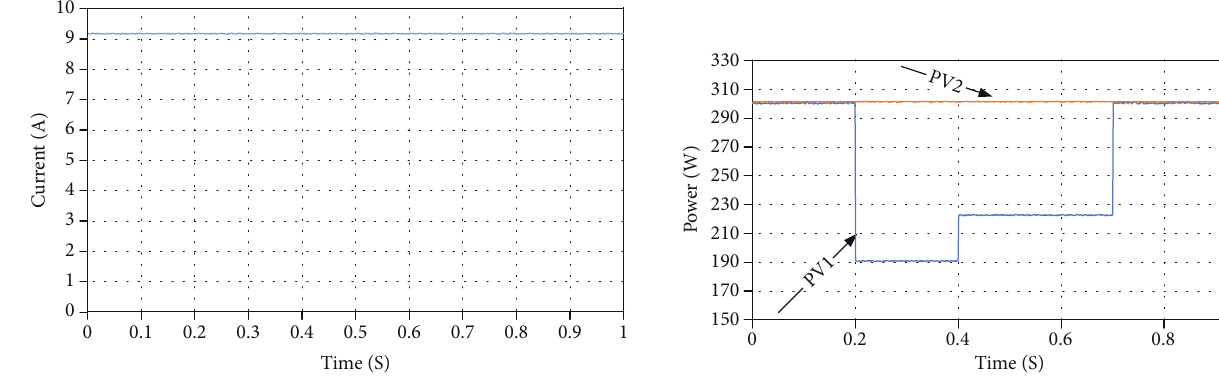
Figure 41: Compare of PV1 and PV2 output